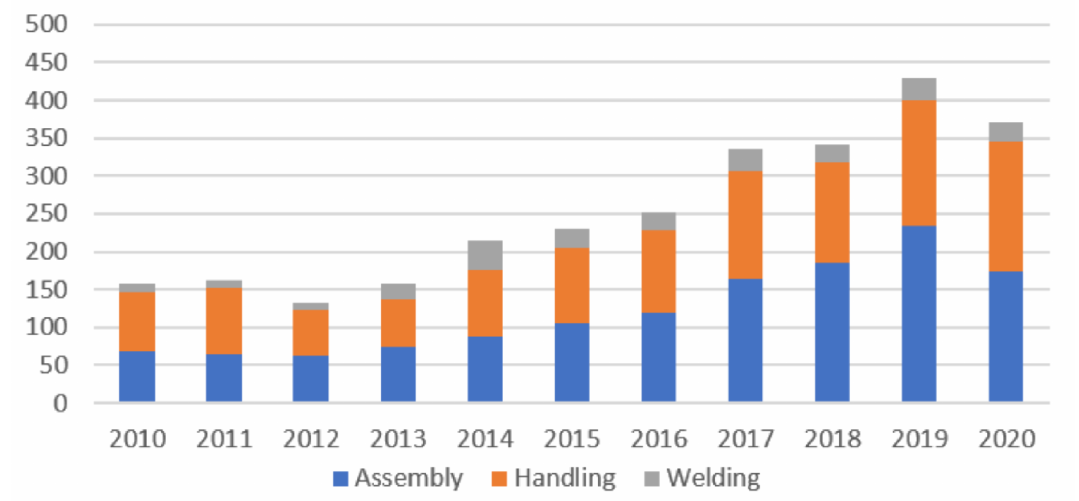
Figure 1. Recent publications of human-robot collaborative (HRC) applications in the three aforementioned